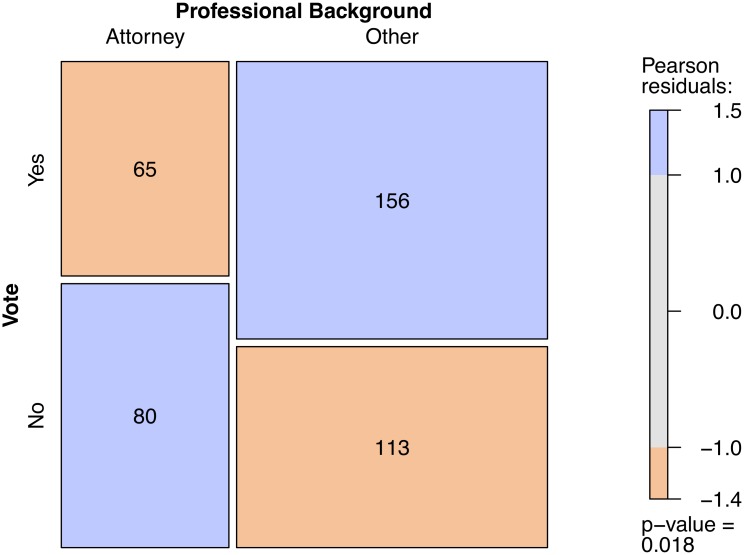
Mosaic plot of votes by professional background.
Notes: Graphical display of the association between the professional backround of a legislator and his or her voting behavior (based on a Pearson chi-squared test of independence, p-value reported in plot). The width of the cells represents the relative share of the professional background categories, while the hight of the cells refers to the proportion of votes within each category. The shading of the cells refers to the sign and magnitude of the respective Pearson residuals. Additionally, the number of observations per cell is presented. Data source: Own compilation based on Project Vote Smart.